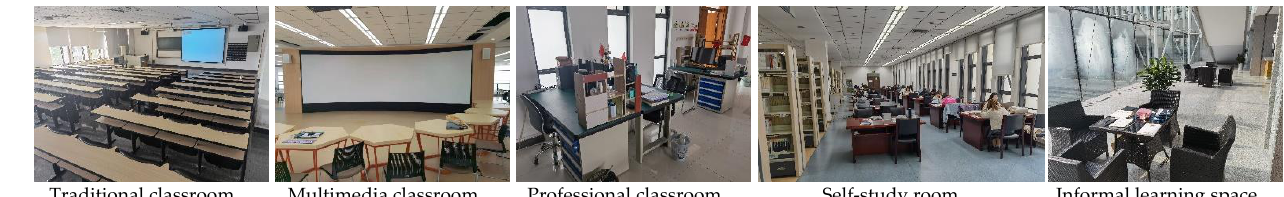
Figure 1. The examples of five typical learning spaces.